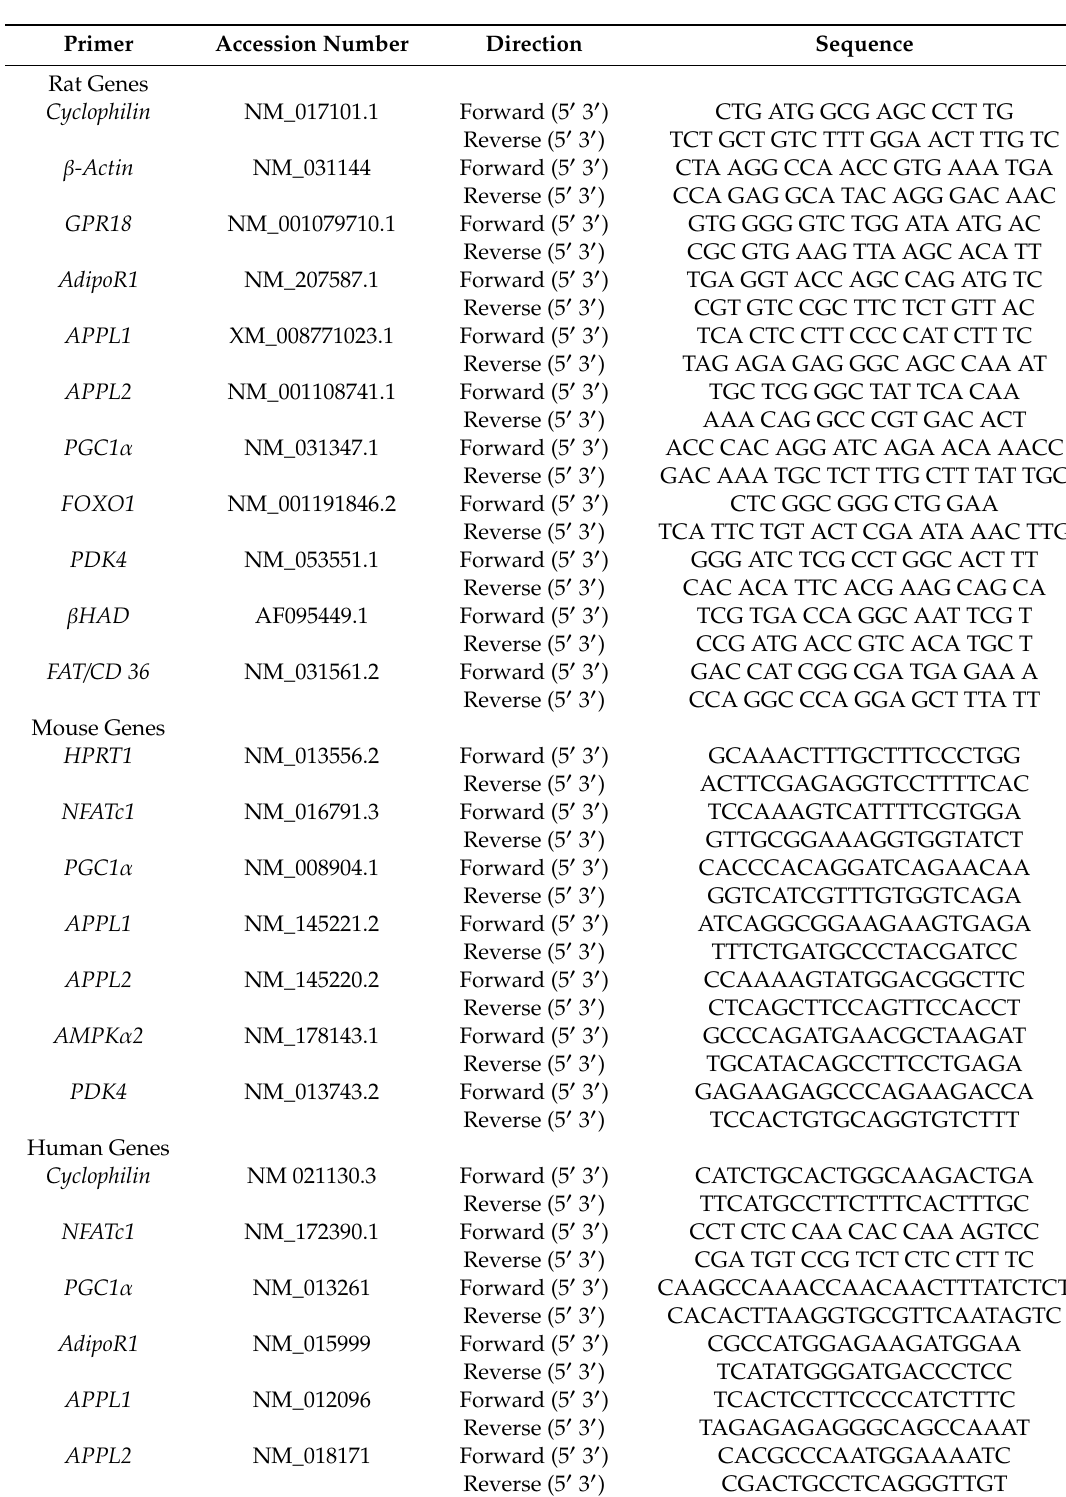
Table 2. Forward and Reverse Oligonucleotide Primer Sequences for ‘Real Time’ Polymerase Chain